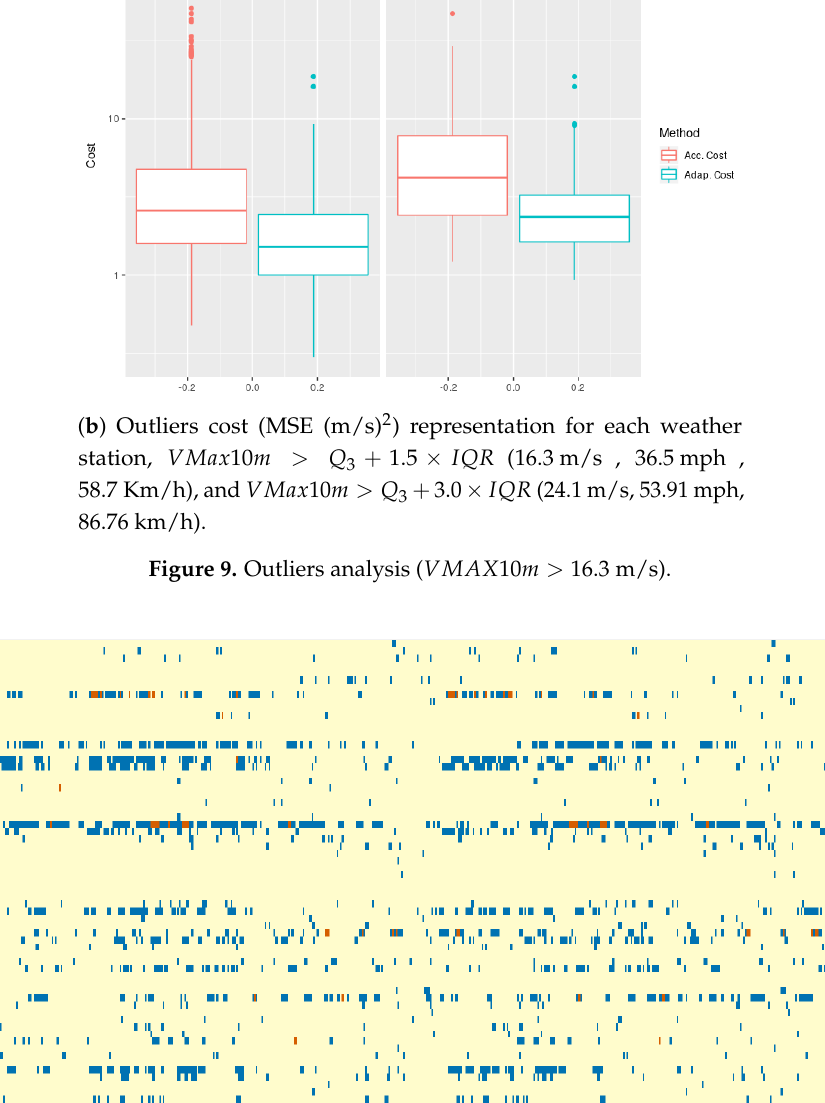
Figure 10. Outliers cost (MSE (m/s) 2 ) representation for each weather station, VMax 10 m > Q 3 + 1.5 × IQR (16.3 m/s , 36.5 mph , 58.7 Km/h), and VMax 10 m > Q 3 + 3.0 × IQR (24.1 m/s, 53.91 mph, 86.76